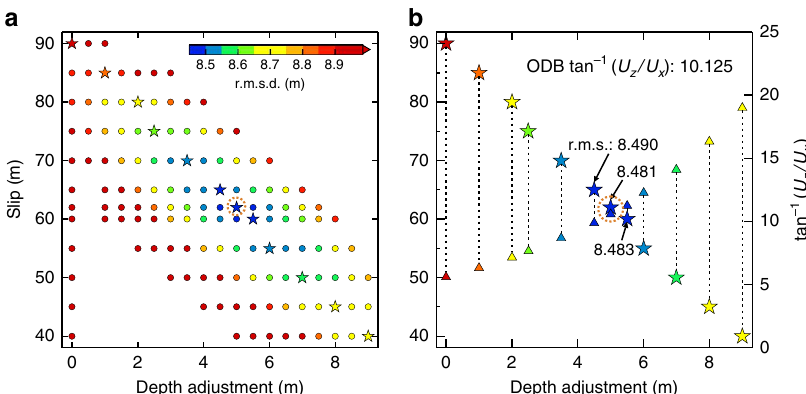
Figure 4 | Search for optimal SDB in the parameter space for the central corridor. ( a ) R.m.s.d.’s of SDB models as a function of average slip and depth adjustment. Slip gradient is fixed at the optimal value (5m increase over 40km) for all the models. Stars represent the best models (lowest r.m.s.d.’s) given slip value. The maximum r.m.s.d. is 12.5m (for 40-m slip and 0-m depth adjustment), but the colour scale saturates at 8.9m. ( b ) Ratio of average vertical to horizontal motion ( U z / U x ) of the seafloor as a function of slip magnitude and depth adjustment. Each star–triangle pair represents one model, with the star being the same as in a (same r.m.s. colour scale) and the triangle showing the corresponding arctangent value of ( U z / U x ). The tan (cid:2) 1 ( U z / U x ) of the optimal SDB agrees with the interpretation of the ODB ( B 10.125 (cid:2) ) through cross correlation 1 . In both panels, the orange dashed circle marks the optimal SDB model shown in Fig. 3.